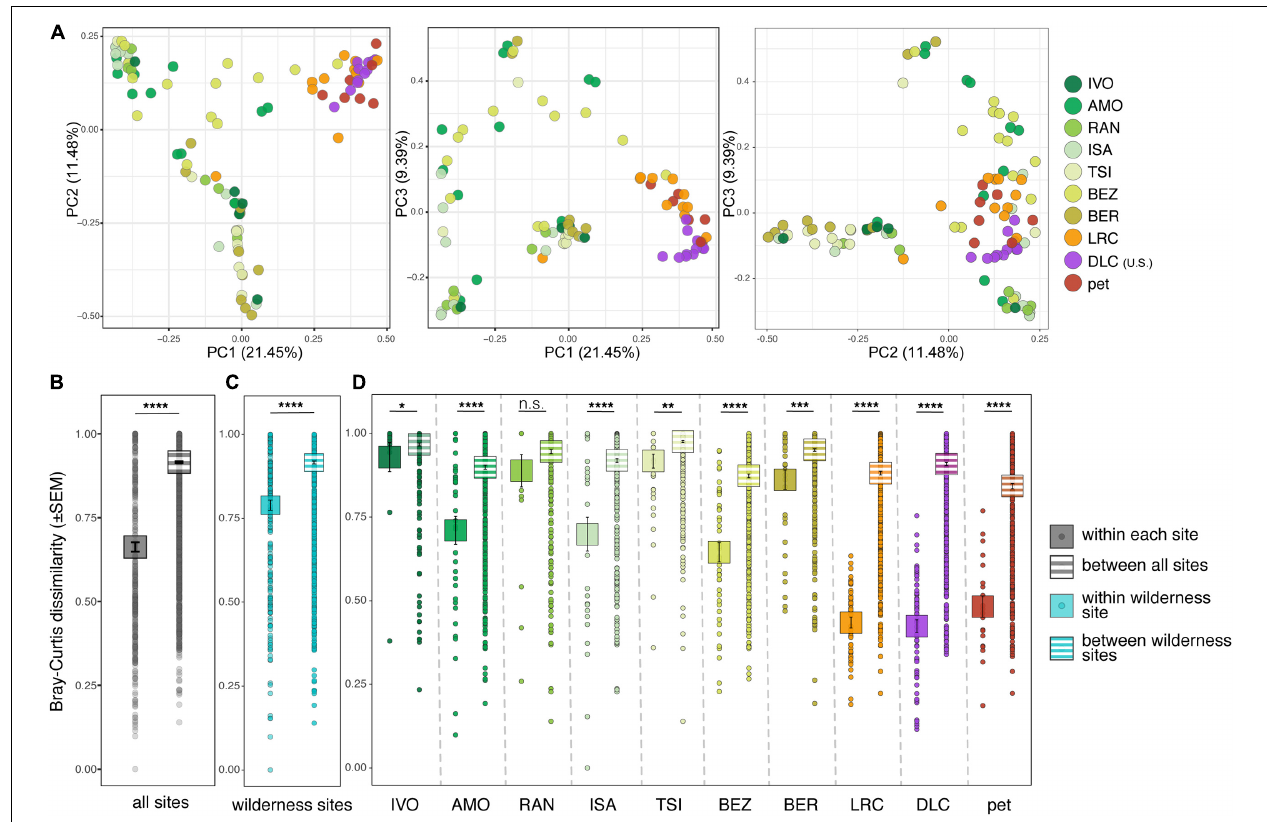
FIGURE 2 | Beta diversity of ARGs in the gut microbiota of ring-tailed lemurs ( Lemur catta ) living at 10 sites (as identified in Table 1 ). (A) Principal coordinate analyses of Bray–Curtis dissimilarity including combinations of axes 1, 2, and 3. Analyses of dissimilarity within or between sites for (B) all lemurs, (C) only wild lemurs, and (D) by site. Sites are presented in ascending order according to the ranked level of anthropogenic disturbance ( Table 1 ). Kruskal–Wallis test with pairwise comparisons and Benjamini–Hochberg correction; * p < 0.05, ** p < 0.01, *** p < 0.001, **** p < 0.0001, n.s.,